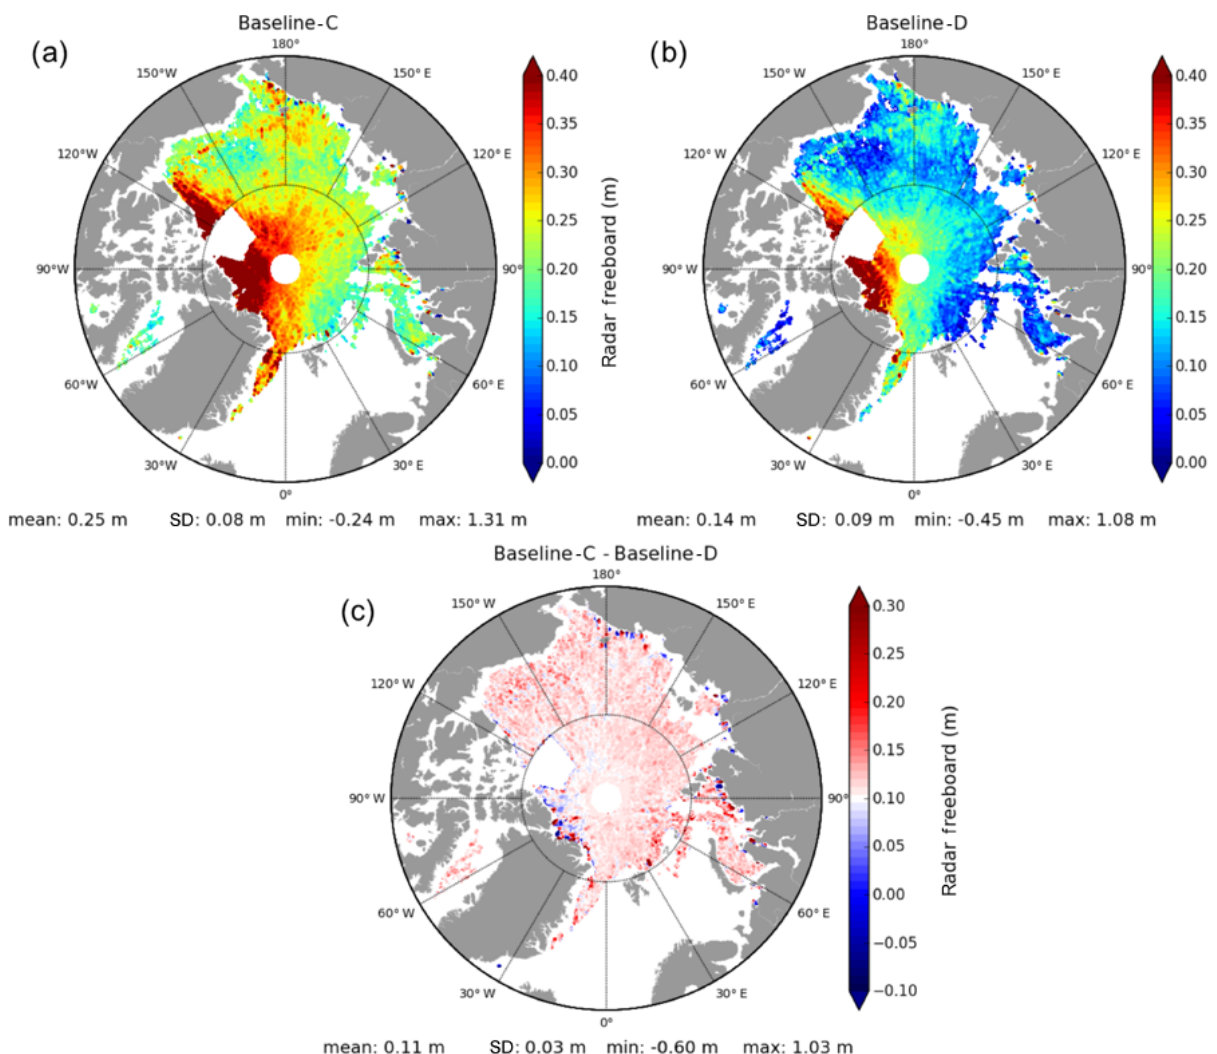
Figure 8. Monthly freeboard maps from 10 March to 11 April 2014 of the (a) Baseline-C and (b) Baseline-D versions. The third map (c) presents the difference between the two previous maps (Baseline-C–Baseline-D). Note that the map (c) color bar is centered on 0.1m to underline the mean bias deviation between the two